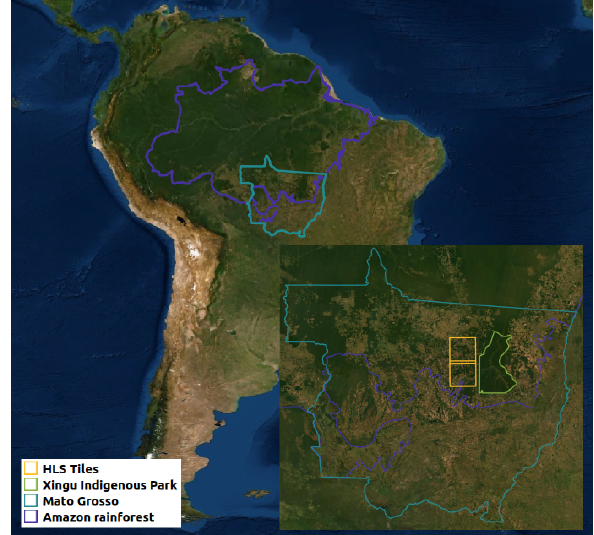
Figure 1. HLS tiles used in this